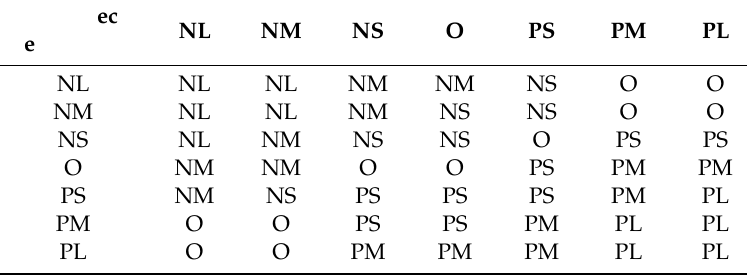
Table 3. The fuzzy table of ∆ K I